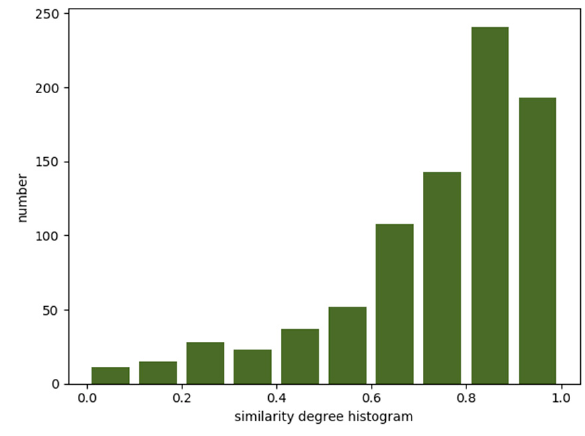
Figure 2. The correlation of the departure flow and arrival flow sequences.